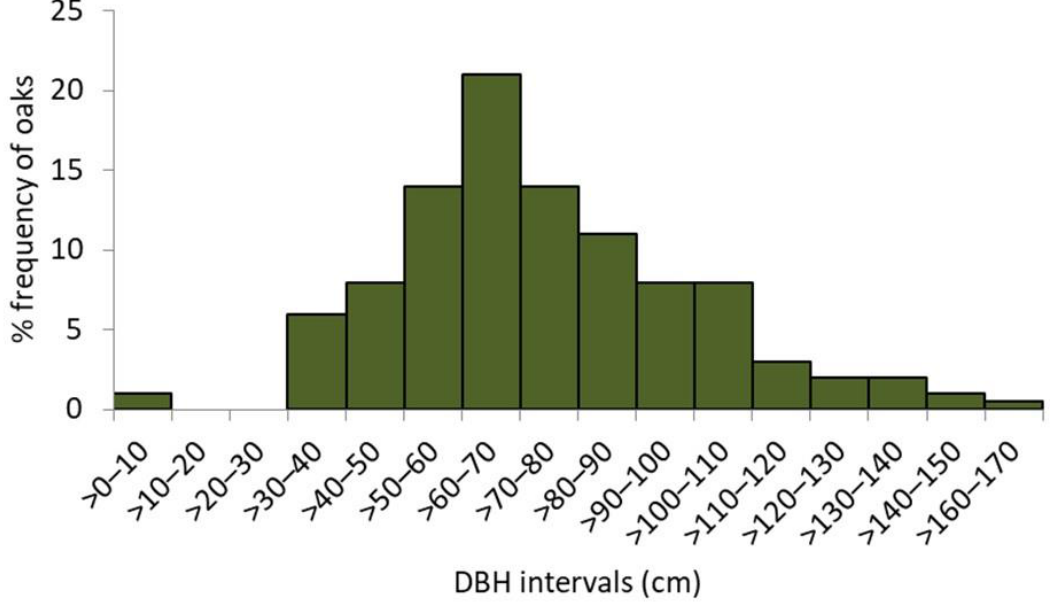
Figure 3. The relative frequency distribution of oaks in 10-centimeter diameter (DBH) classes; n =